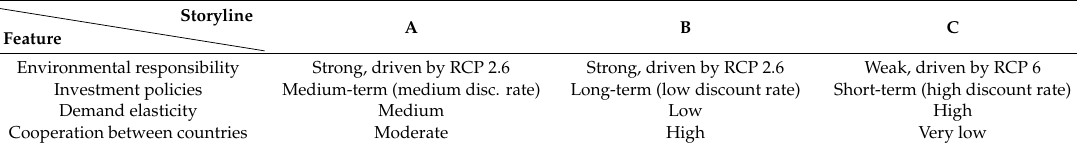
Table 9. Summary of the main features of the EUROFusion TIMES Model (ETM) storylines